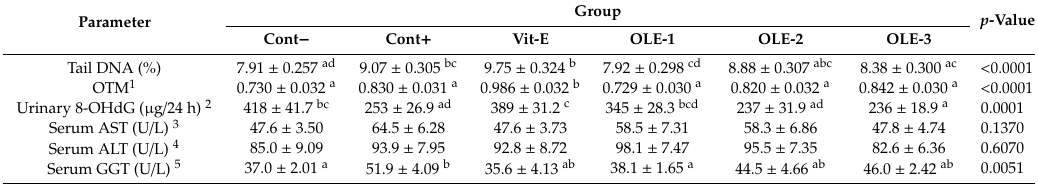
Table6. DNAdamagemarkersandliverenzymesactivitiesinpigletsfedtheexperimental( n = 8 / group).